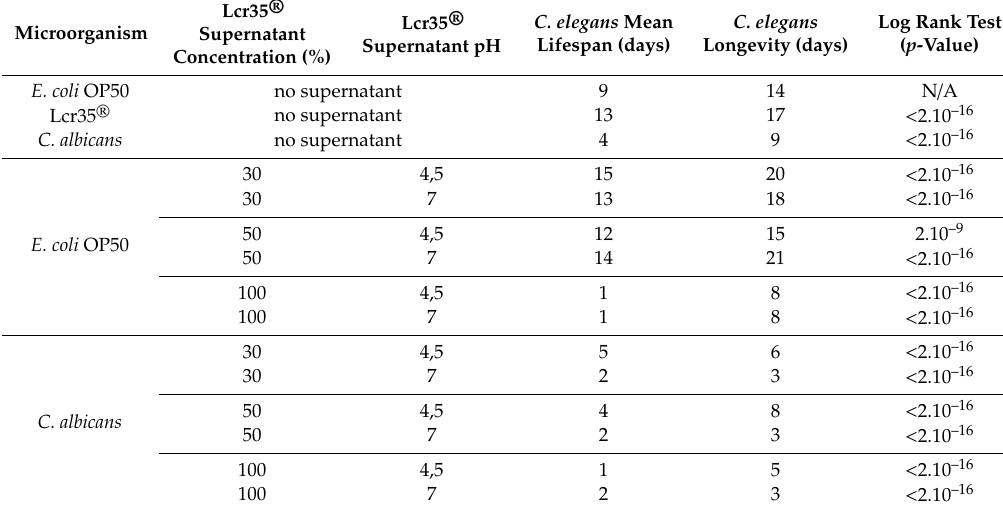
Table 1. E ff ects of Lcr35 ® cell-free supernatant on C. elegans survival, worms previously fed on E. coli OP50 or C. albicans . Log rank test was performed with E. coli OP50 without Lcr35 ® supernatant as a